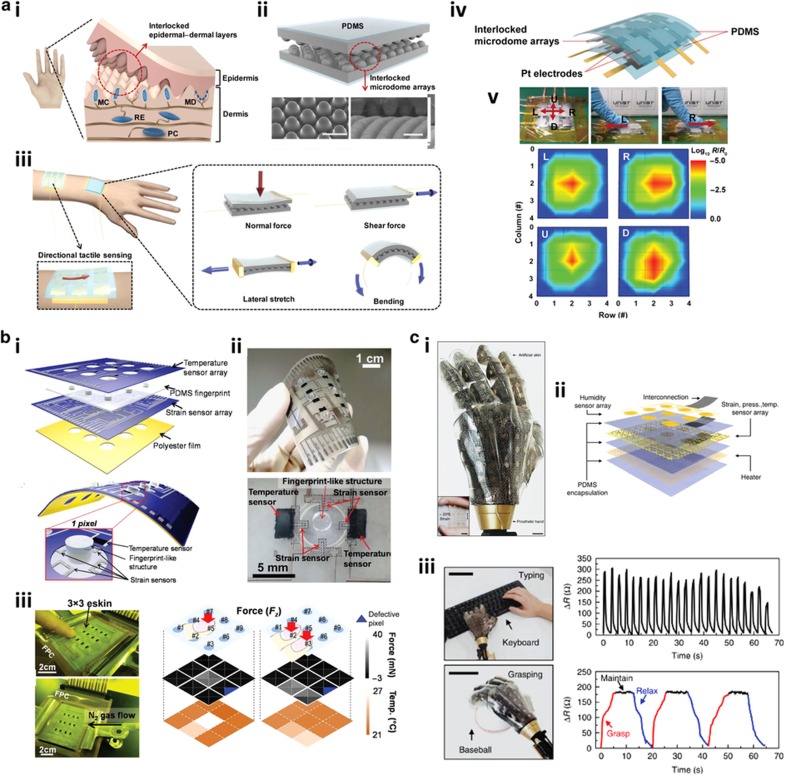
Flexible and stretchable physical sensing platforms for artificial electronic skins. (a) Stretchable e-skin configured from CNT-PDMS composite film patterned with interlocked microdome arrays. (i) Schematic illustration of the structure of human skin depicting the interlocked epidermal–dermal layers and the various skin mechanoreceptors. (ii) Schematic illustration of the design of the interlocked microdome arrays and the corresponding tilted and cross-sectional SEM images of the arrays of microdomes on a composite film. Scale bars, 5 μm. (iii) Schematic illustration showing the attachment of the stress-direction-sensitive e-skin on a human arm for the directional tactile sensing and differentiation of a range of mechanical stimuli, such as normal, shear, lateral stretch, and bending forces. (iv) Schematic illustration showing the configuration of 3×3 pixel e-skin arrays sandwiched between the cross-arrays of electrodes and PDMS layers for the three-axial directional sensing of mechanical stimuli. (v) Spatial distribution and directional mappings of external finger pushes applied on the e-skin. Adapted with permission from Ref. 7. Copyright 2015 American Chemical Society. (b) Strain-engineered artificial e-skin sensor arrays integrated with a fingerprint-like structure. (i) Schematic illustration showing an exploded view of the device configuration with the corresponding enlarged view of the fingerprint-like structure with its four strain and one temperature sensors. (ii) Optical image showing the actual fabricated e-skin device in a 3×3 array (top) and the corresponding enlarged image of the actual fabricated fingerprint-like structure (bottom). (iii) Optical image and schematic illustrations depicting the two-dimensional force and temperature mapping capability of the 3×3 array e-skin device in response to external stimuli, such as finger touch. Scale bars, 2 cm. Adapted with permission from Ref. 46. Copyright 2015 American Chemical Society. (c) Smart prosthetic e-skin sensor constructed from stretchable silicone nanoribbon (SiNR) electronics. (i) Optical image illustrating the smart artificial e-skin with its stretchable SiNR electronics laminated compliantly onto a prosthetic hand. Inset shows a 20% stretched e-skin. Scale bars, 1 cm. (ii) Schematic illustration depicting the exploded view of the device architecture of the smart e-skin. (iii) Optical images of the e-skin-laminated prosthetic hand tapping a keyboard and grasping a baseball and the corresponding temporal resistance changes of the artificial e-skin in response to different external stimuli as captured and monitored by the pressure sensor. Adapted with permission from Ref. 8. Copyright 2014 Macmillan Publishers Limited.